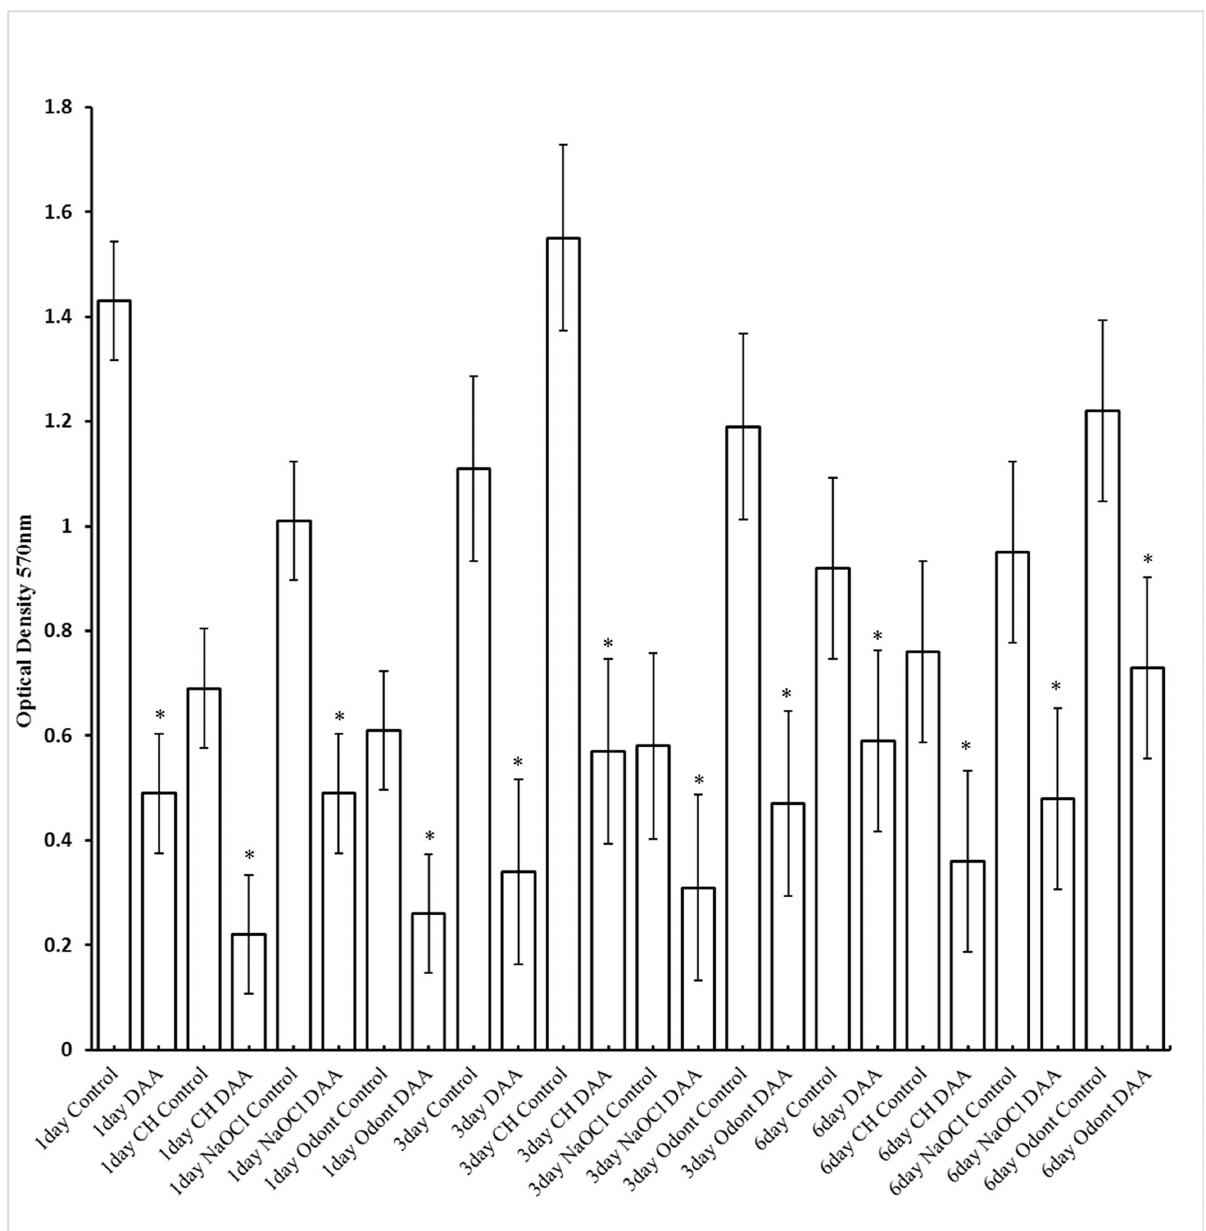
Fig 5. Mean density (570nm) of Control group (no D-amino acids) versus treatment groups. Biofilm growth followingstaining of E. faecalis biofilms with crystal violet. The medicaments Odontopaste ™ (Odont), Odontocide ™ (CH) and the irrigant, sodium hypochlorite (NaOCl) were added separately with D-Leu, D-Met and D-Trp (25mM) and 0.25mM D-Tyr at the time of inoculationfor the 1day biofilm, then 1 day and 3 days for the 3 and 6 day biofilm respectively. Asterisk denotes a significantreduction in biofilm growth comparedto controls (medicament or irrigant